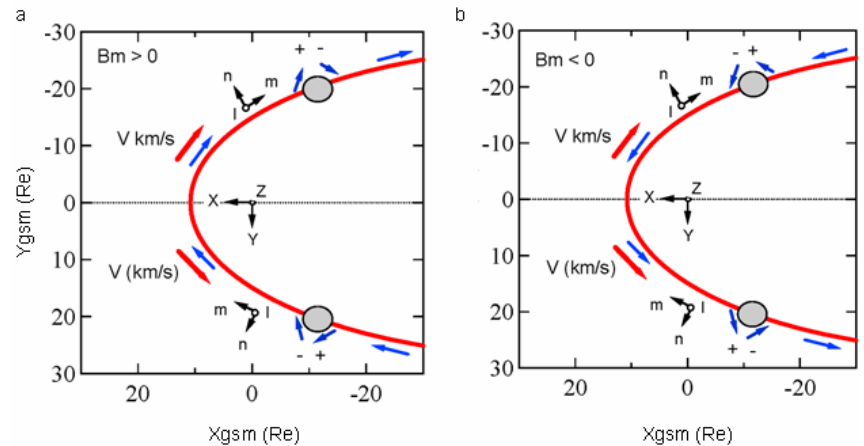
Fig. 2. Polarities of magnetosheath FTEs in the GSM X-Y plane expected for (a) dawnward and (b) duskward interplanetary magnetic fields (blue arrows). Red arrows show direction of antisunward motion of plasma in the magnetosheath. Antisunward moving events should produce reverse ( − , + ) signatures at pre-noon local times, but direct ( + , − ) signatures at post-noon local times for dawnward IMF B y < 0 (Bm > 0) and direct ( + , − ) signatures at pre-noon local times and reverse ( − , + ) signatures at post-noon local times for duskward IMF B y > 0 (Bm < 0).